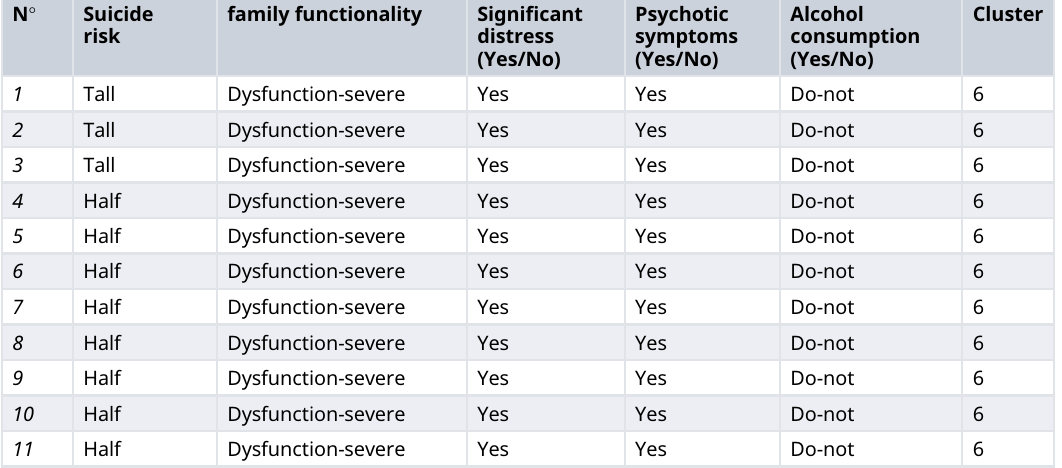
Table 1. Focal group selected by Gower's